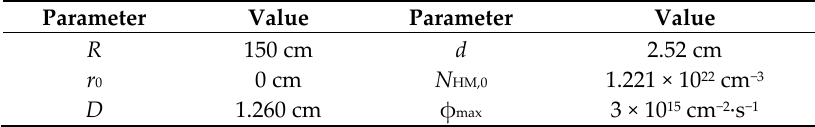
Table 1. Parameters used in examples. HM: heavy